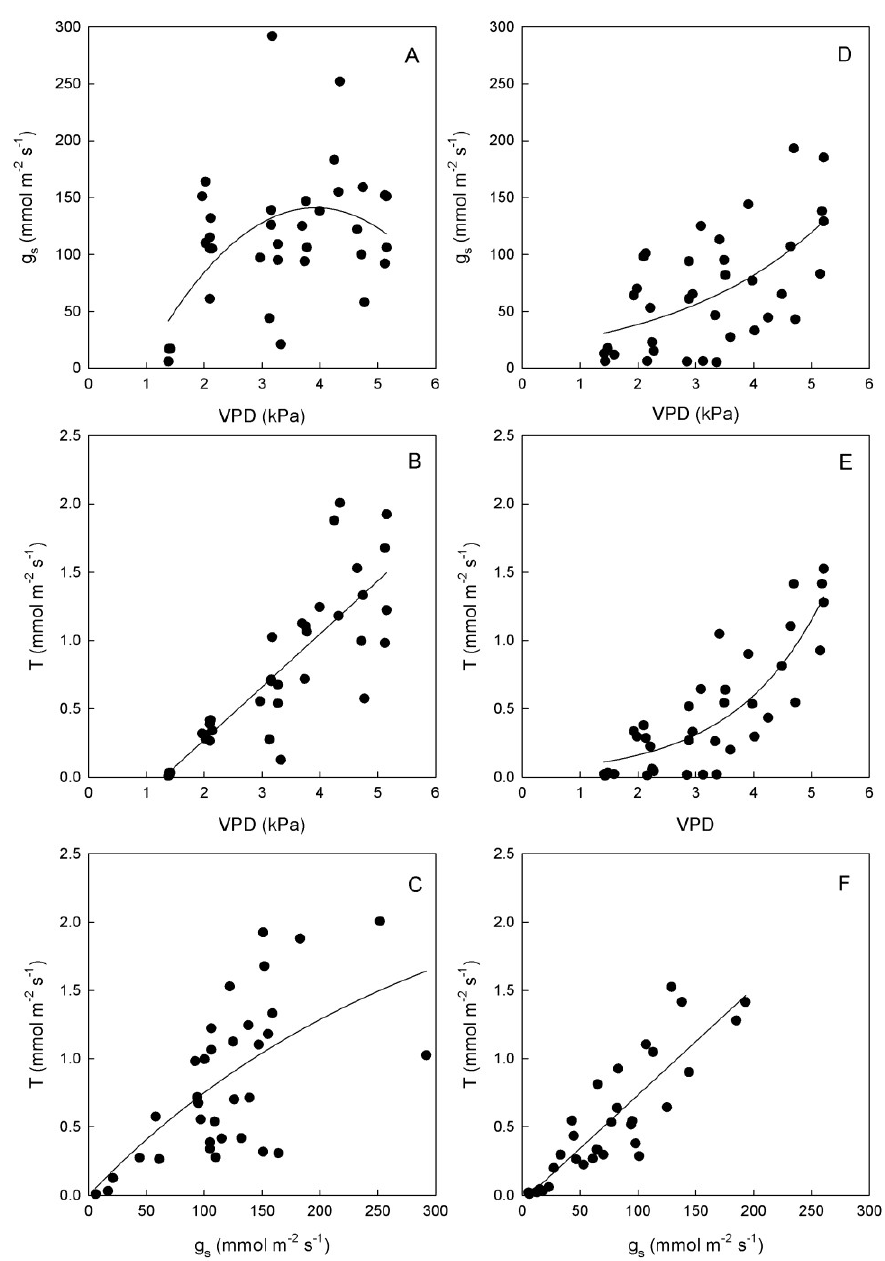
Figure 4. Relationships between vapor pressure deficit (VPD) and stomatal conductance (g ) or transpiration rate (T), and between g and T in leaves of ( A – C ) ‘Biancolilla’ and s s ( D – F ) ‘Cerasuola’ olive trees during a typical summer day in Sicily. In ‘Biancolilla’, T = Ln (0.83 + 0.013 g ); R 2 = 0.486, p < 0.001; T = −0.50 + 0.39 VPD; R 2 = 0.694, s p < 0.001; g = −95 + 120 VPD − 15.3 VPD 2 ; R 2 = 0.265, p = 0.006. In ‘Cerasuola’, s T = −0.05 + 0.008 g ; R 2 = 0.782, p < 0.001; T = 0.04 × 1.93 VPD ; R 2 = 0.706, p < 0.001; s g = exp(2.90 + 0.38VPD); R 2 = 0.353, p < 0.001. Models tested by regression analysis and s best equation chosen according to Schwarz’s Bayesian Information